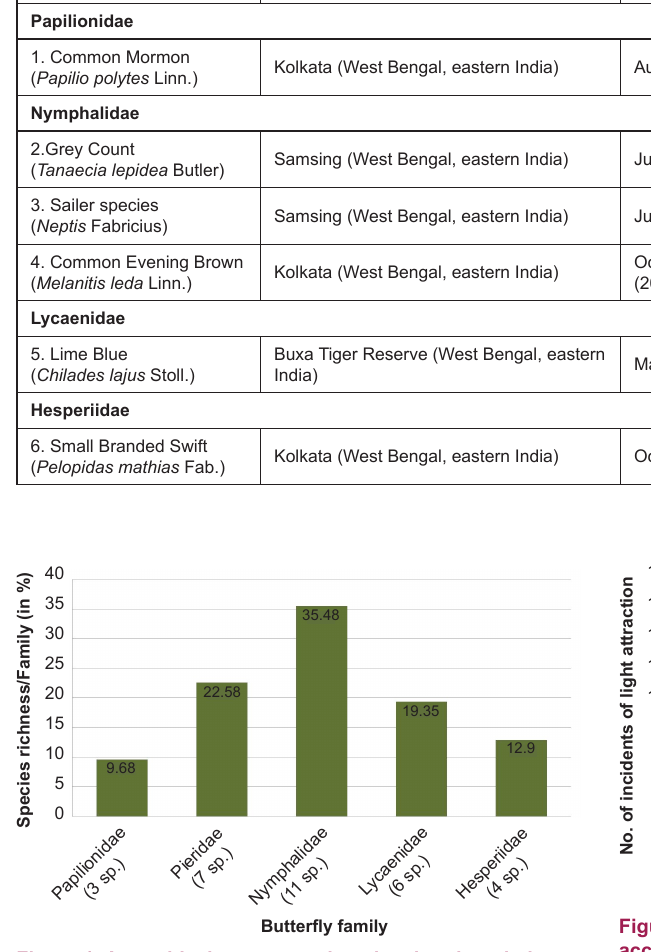
Figure 1. A graphical representation showing the relative richness for light-attracted butterfly species in terms of their families (1951–2009).